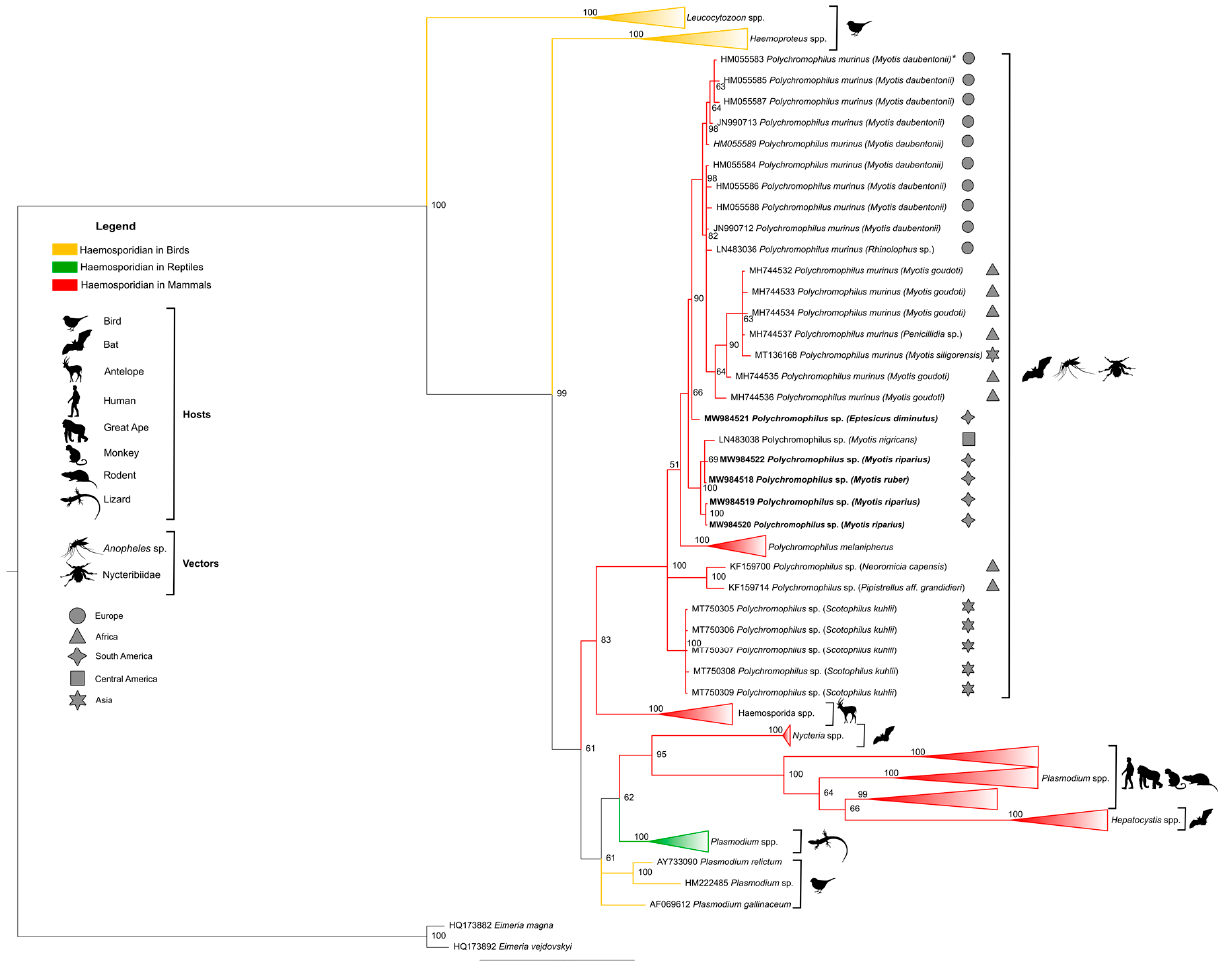
Figure 3. Bayesian phylogeny based on the mitochondrial cytochrome b gene ( cytb ) from Polychromophilus spp. of the sequences identified in the present study (1116 bp) and reference sequences listed in Tables A1 and A2 in Appendix A. * Sequence HM055583 has also been reported in P. murinus from Eptesicus serotinus , Nyctalus noctule , and Myotis myotis (Table A2, Appendix A). Eimeria spp. were used as an external group. The support values of the nodes (in percentage) indicate posterior probabilities. The red branches highlight the haemosporidian sequences found in mammals. The yellow branches highlight the haemosporidian sequences found in birds. The green branches highlight the haemosporidian sequences found in reptiles. The sequences found in the present study are highlighted in bold. The remaining reference sequences are collapsed to highlight the branch of the Polychromophilus